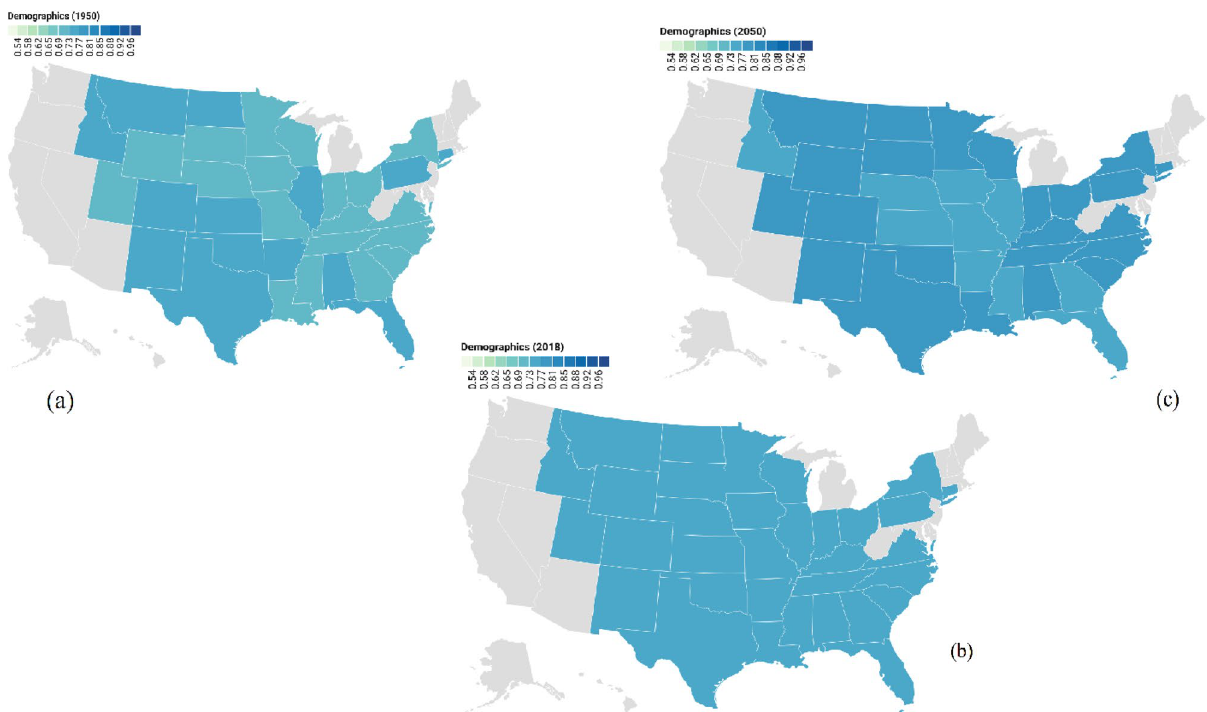
Fig. 4 Counterfactual calculations of the probability of at least five fatalities occurring as a result of a tornado outbreak across U.S. states with different demographic scenarios. Panel a shows the expected